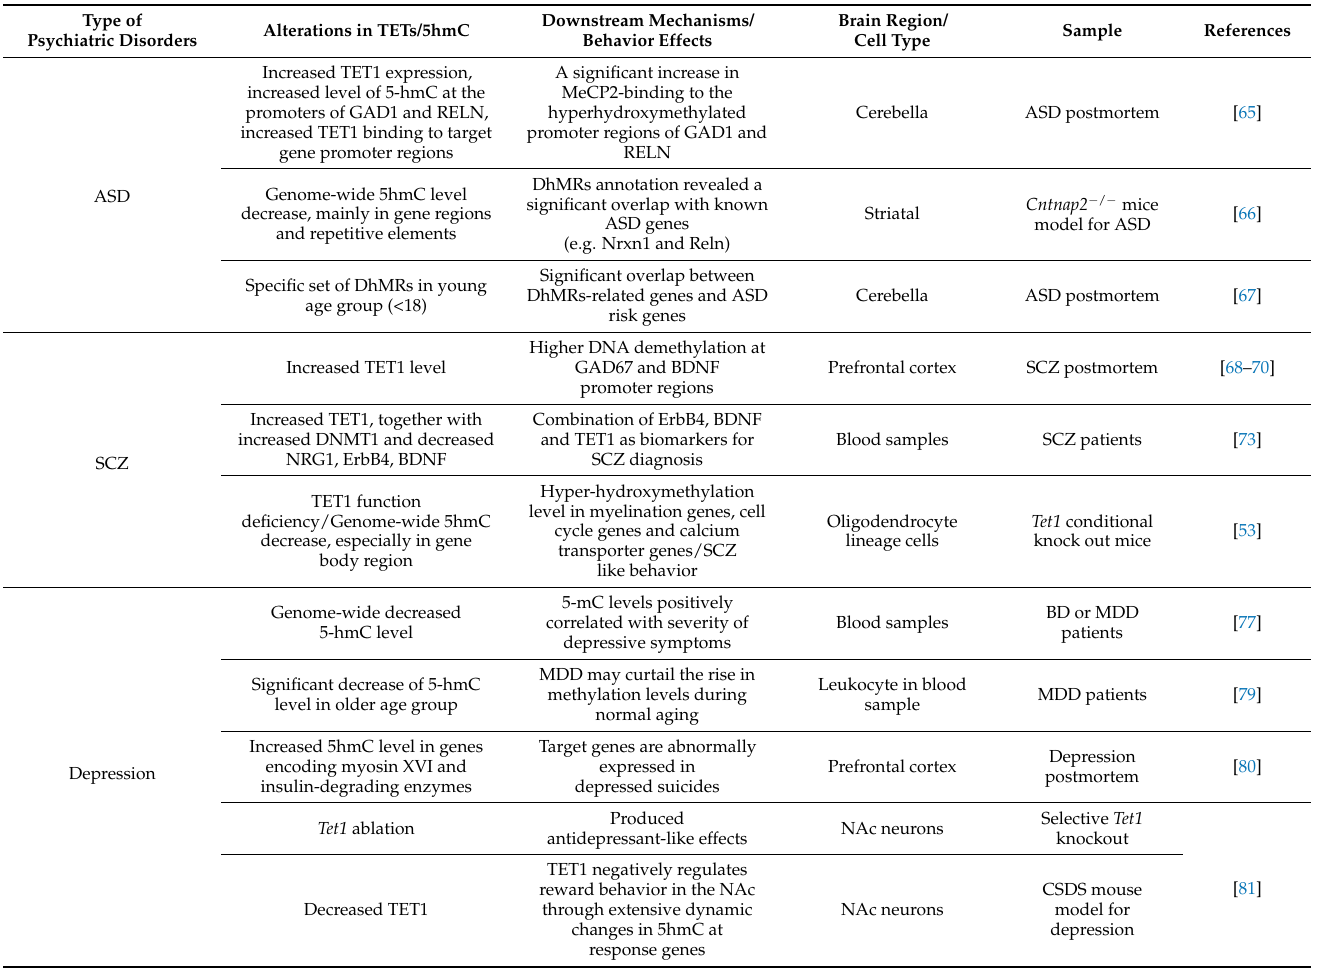
Table 1. TETs and 5hmC in different psychiatric